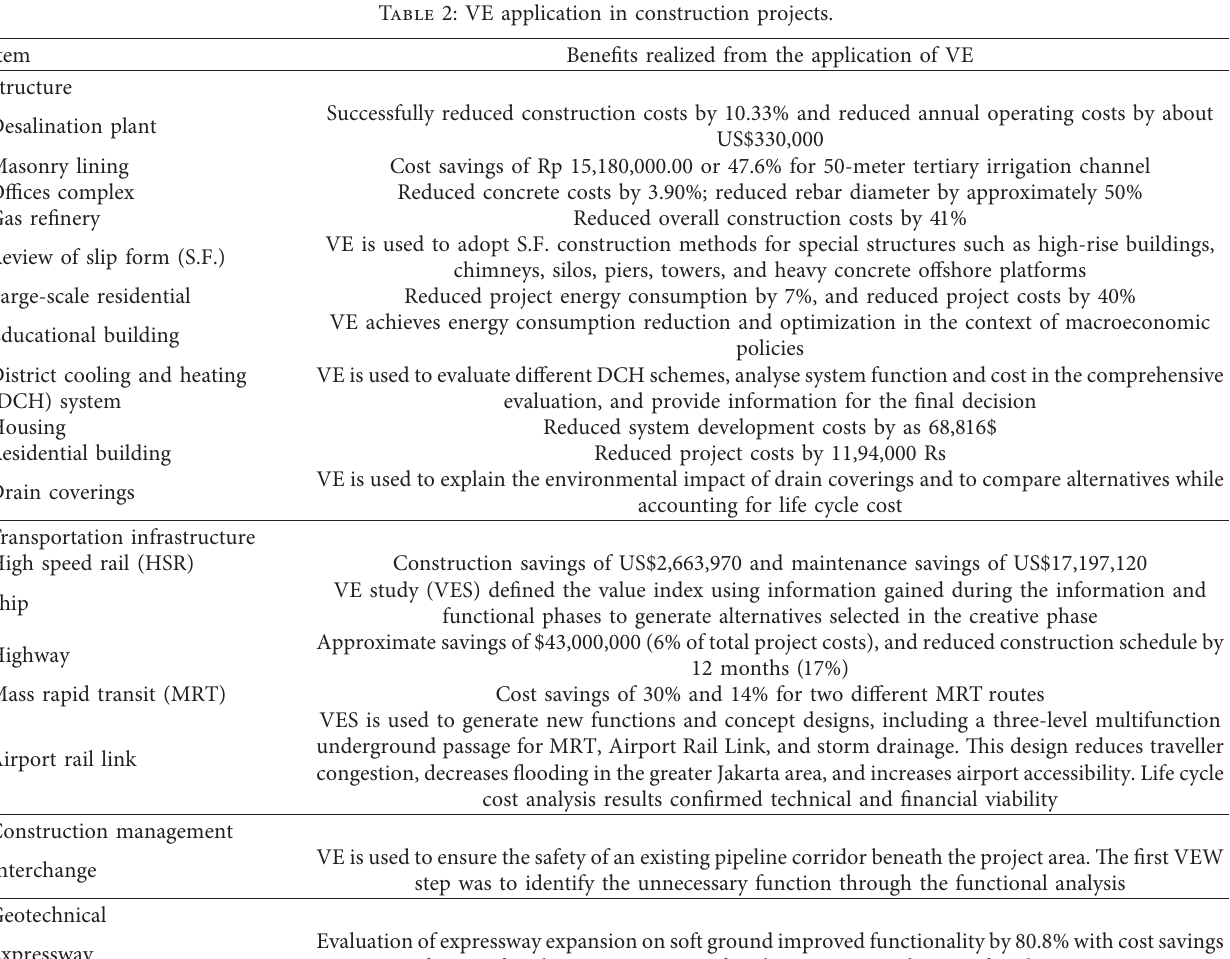
Table 2: VE application in construction